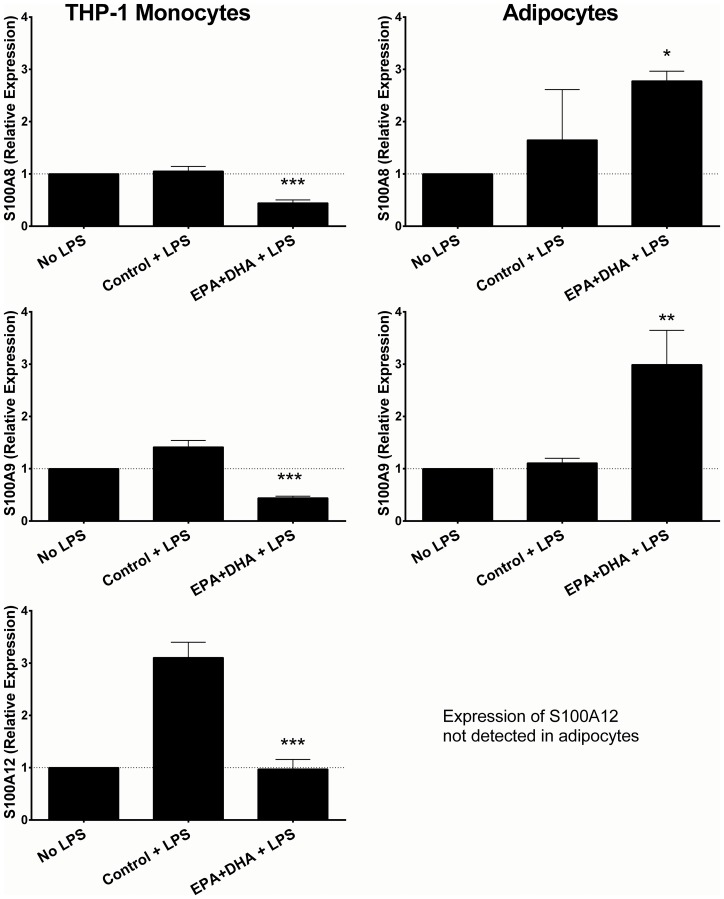
Expression of calgranulin genes (S100A8, S100A9, S100A12) in response to stimulation with LPS is modulated by n-3 PUFA treatment in human THP-1 cells and adipocytes.*** indicates p<0.001; ** indicates p<0.01; * indicates p<0.05. Data plotted as mean fold change and standard deviation.